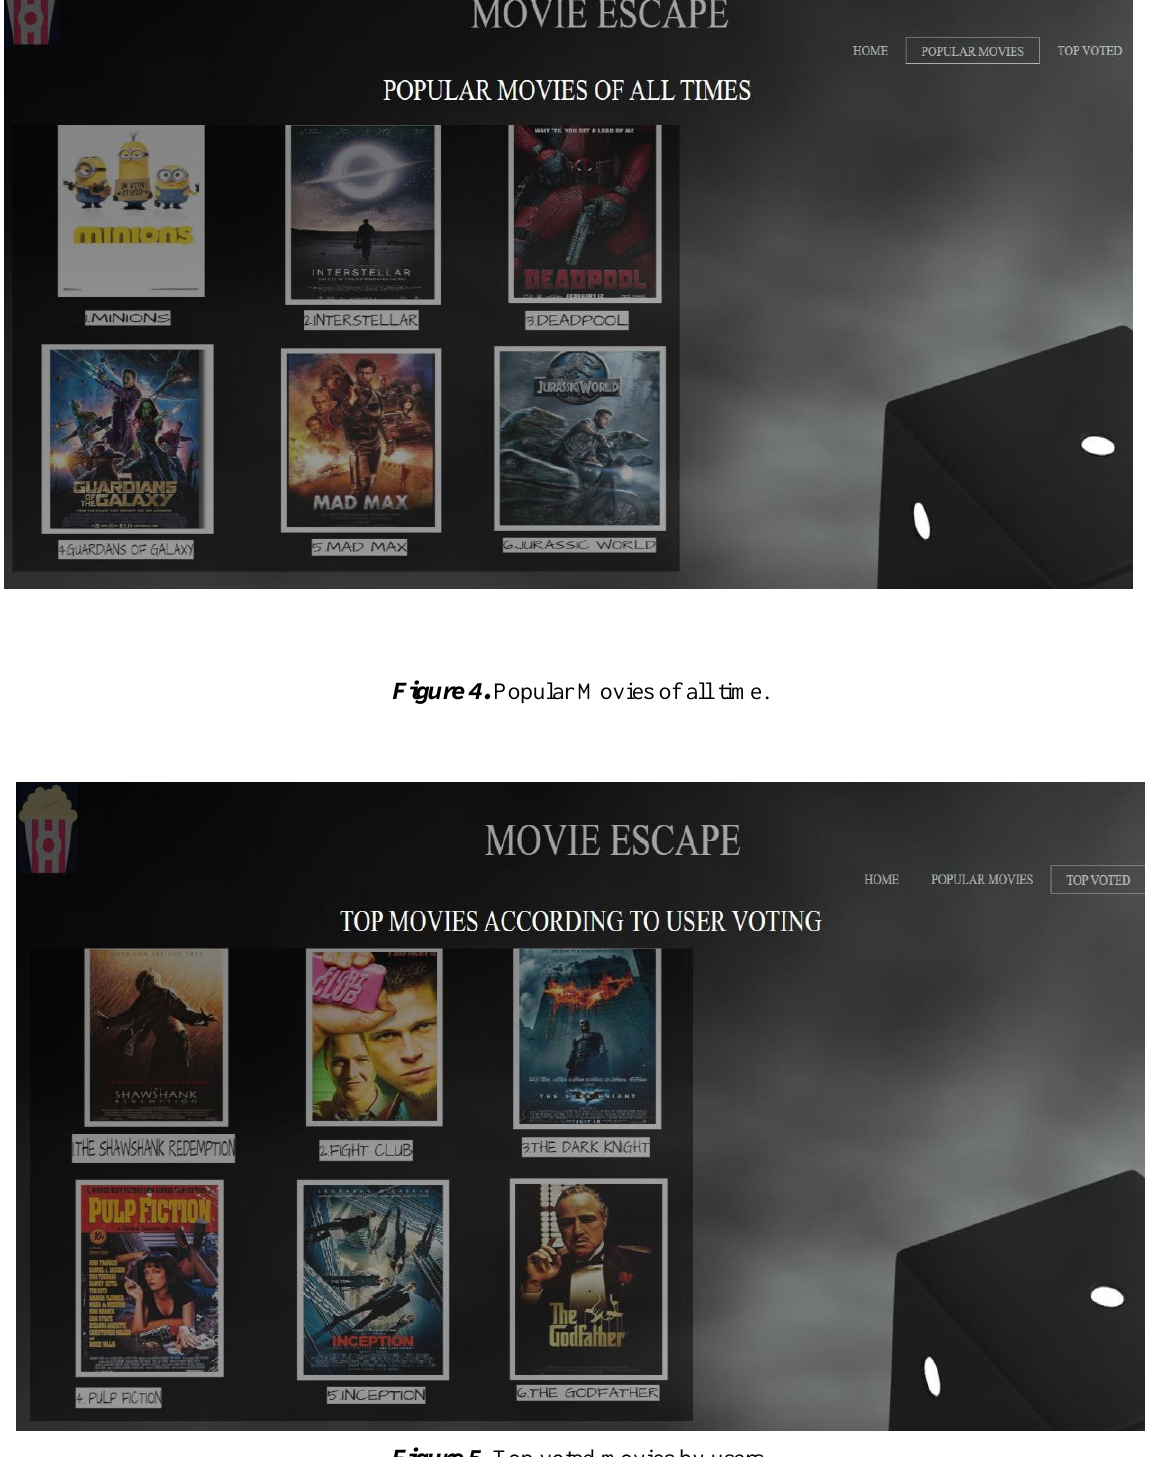
Figure 5. Top voted movies by